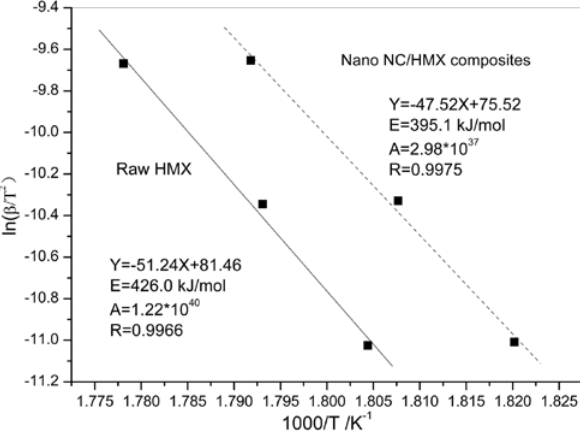
2 ) versus reciprocal peak tem- Figure 5: Kissinger’s plots of ln( β / T p perature 1000/ T for raw and nano NC/HMX composites particles. p Symbol R is used to identify the linear correlation coefficient of 2 ) to 1000/ T ln( β / T . p p